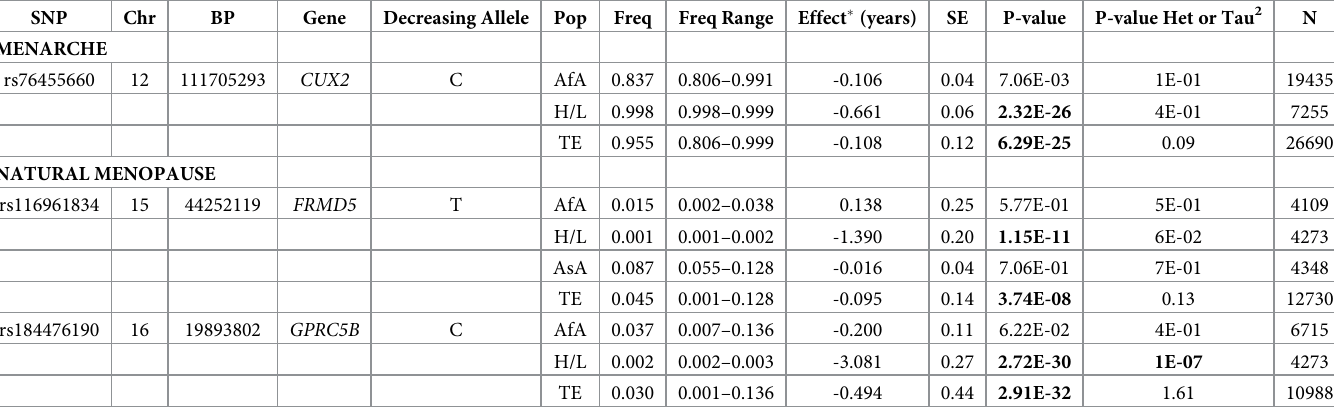
Table 4. Three loci with trans-ethnic array-wide significant modified random-effects associations (cid:3) at novel age at menarche or natural menopause